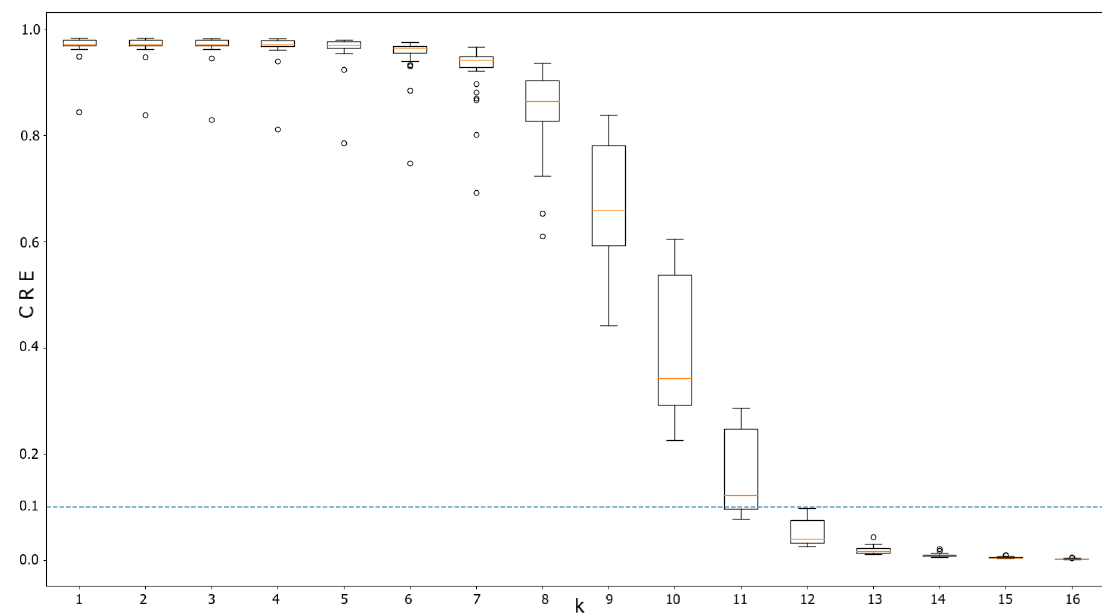
Figure 2. Box plot for Cumulative Relative Entropy for different k sizes involving 30 bacterial genomes. The suggested threshold is below 0.1 to maximize differences between the genomes. Notice that k = 13 is the first k where neither value is above the threshold.